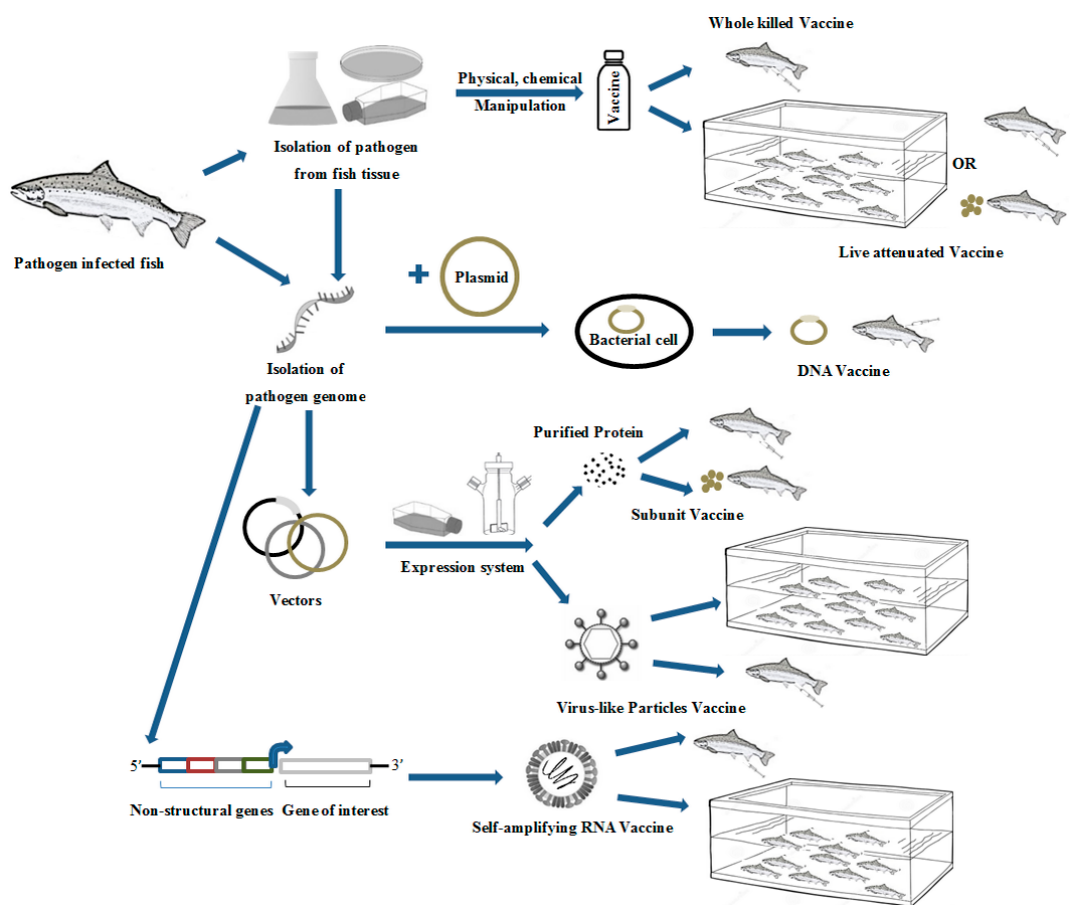
Figure 1. Various approaches for fish vaccine development. On the left side are preparatory components, followed by production means in the middle, and final administration routes to the right. Individual fish receiving an injection denote the injection vaccination, while fish consuming the feed pellets represent administration via oral uptake. The grouped fish within the tank represent immersion as a vaccination route.